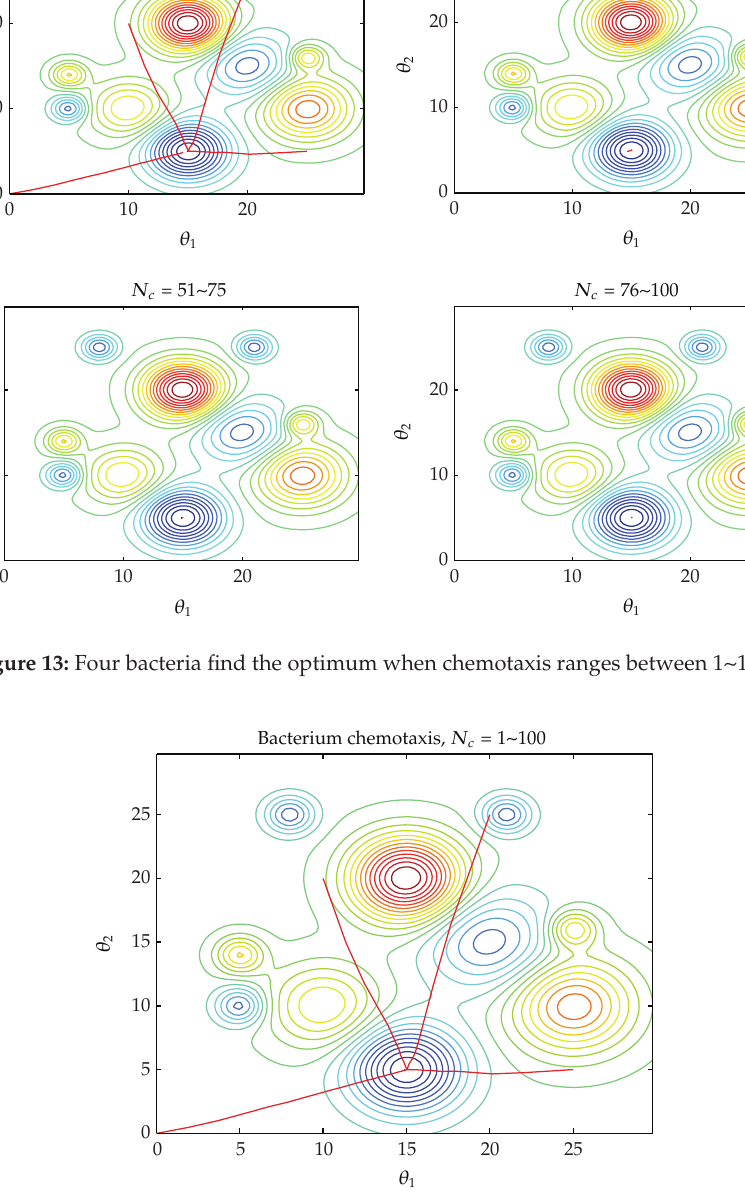
Figure 14: Optimal process of four bacteria when chemotaxis ranges between 1 ∼